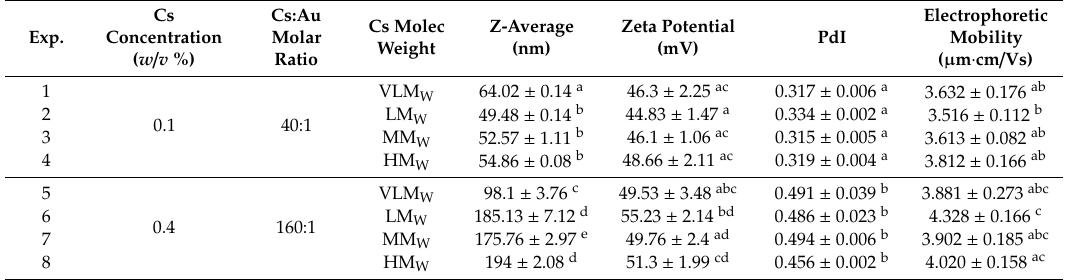
Table 2. Physical parameters of the Cs-AuNPs synthesized in the experiments 1 to 8.